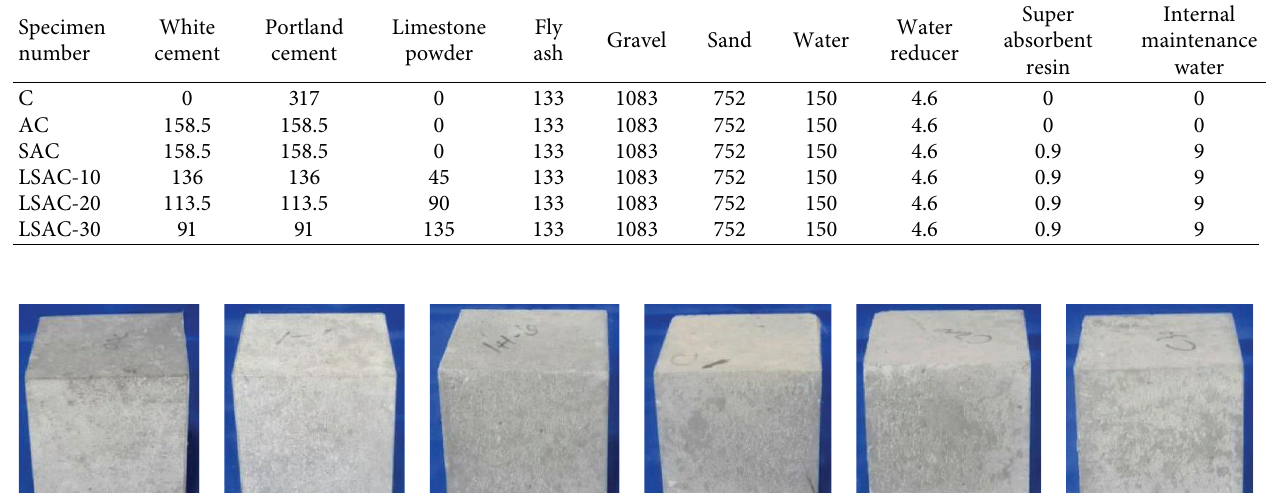
Table 2: Mixing ratio of fair-faced concrete (kg/m 3 ).